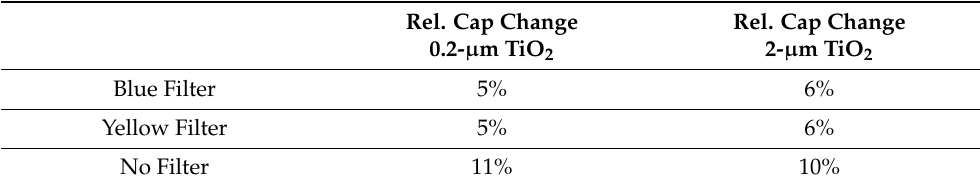
Table 1. Relative capacitive change using C-V measurements with a 2-electrode setting when illuminated by a 75 W white-light source. Similar results were obtained using electrochemical impedance spectroscopy (EIS).